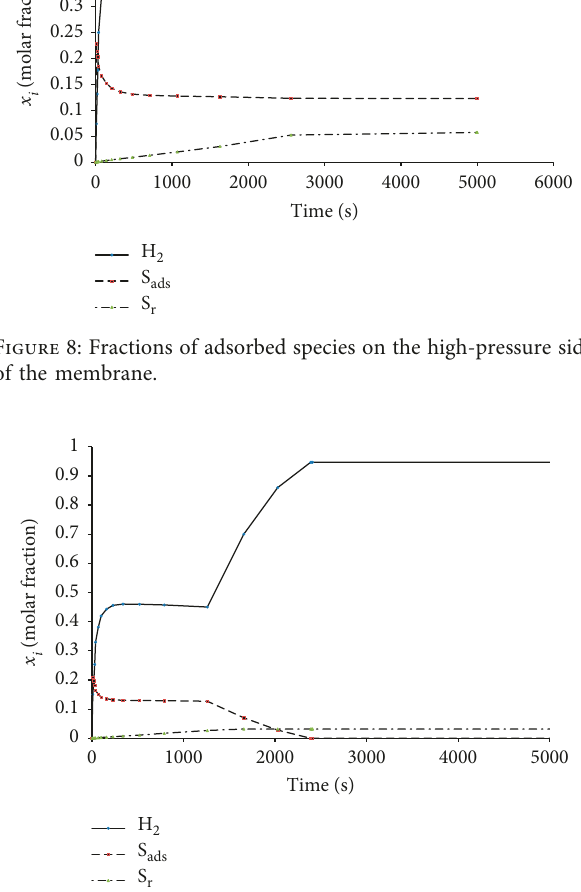
Figure 11: Time variation of adsorbed species before and after removing sulfur contamination.